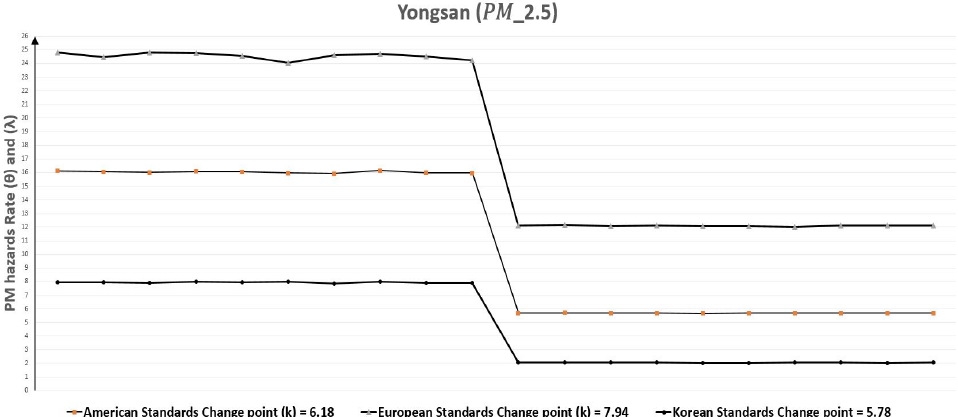
Figure 24. Yongsan (Seoul, South Korea) monthly polluted days before and after the change point due to PM 2.5